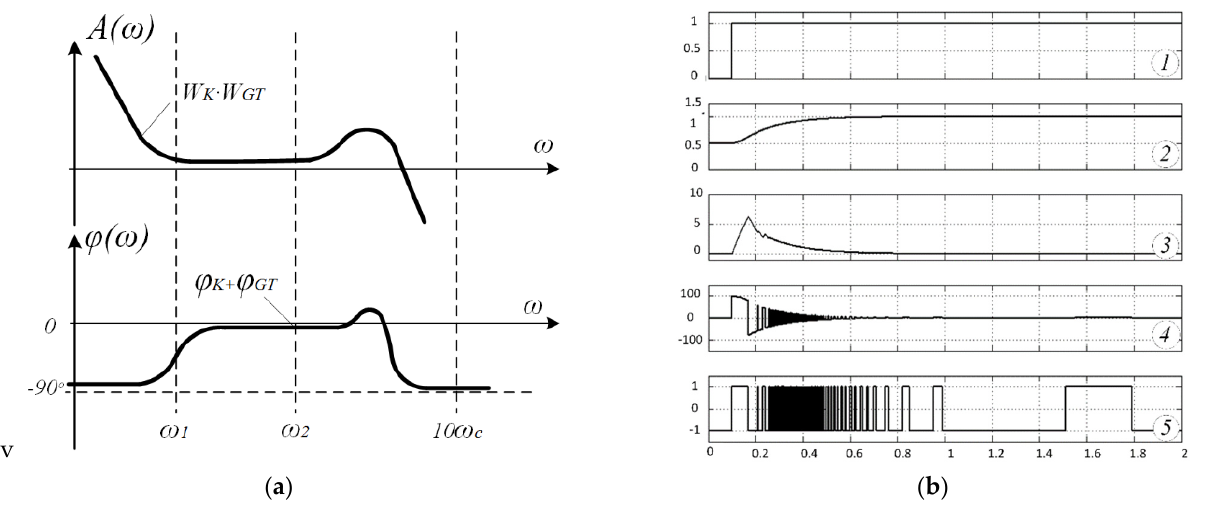
Figure 11. Logarithmic amplitude–frequency characteristics of VSS ( a ) and transient processes in the model with zero time delays ( b ) 1 Reference signal. 2 Adjustable value. 3 Derivative. 4 Signal at the output of the slip driver. 5 Output of the relay element “Relay”.